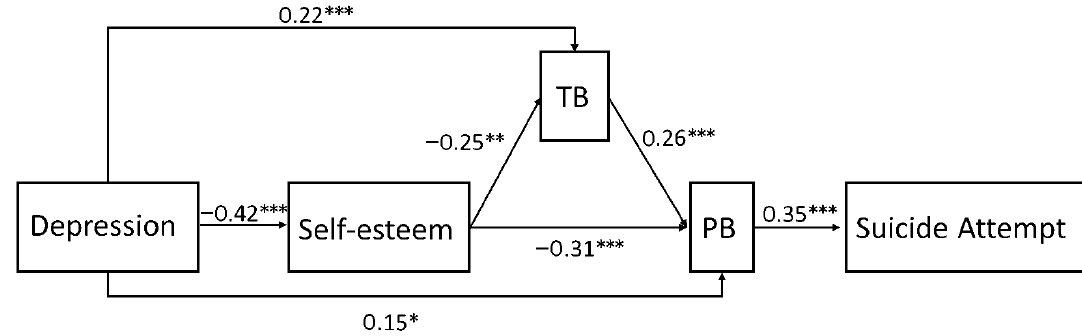
Figure 1. The mediating effect of self-esteem and interpersonal needs in the association between depression and suicidal attempt. * p < 0.05, ** p < 0.01, *** p < 0.001.